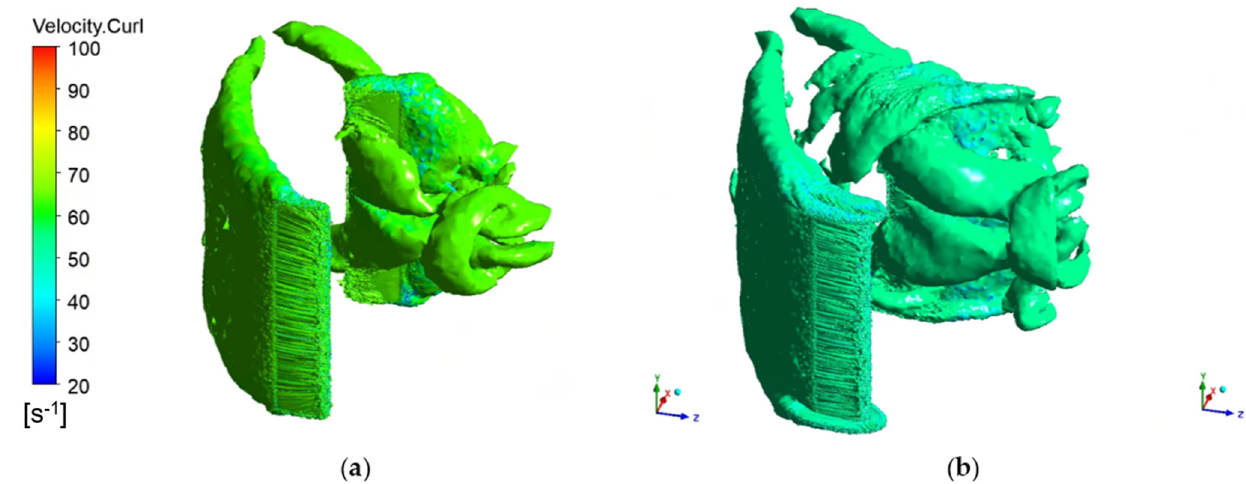
Figure 9. Vorticity of ( a ) baseline; ( b ) offset endplate at θ = 90° in TSR 1.